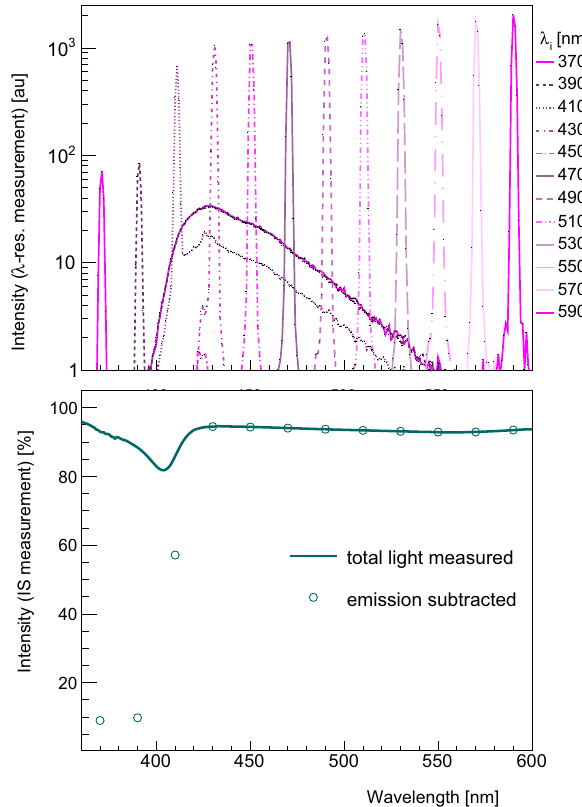
Fig. 6 Measurements of a TTX+TPB sample. Top: wavelength- resolved spectra for each λ i . The peak of reflected light R (λ i ) is at the position of λ i , and for λ i (cid:2) 410nm, a broad peak of shifted emis- sion E (λ i ) is also present. Bottom: integrated intensity I IS (λ i ) before ( ) and after ( ◦ ) correction of the emission fraction